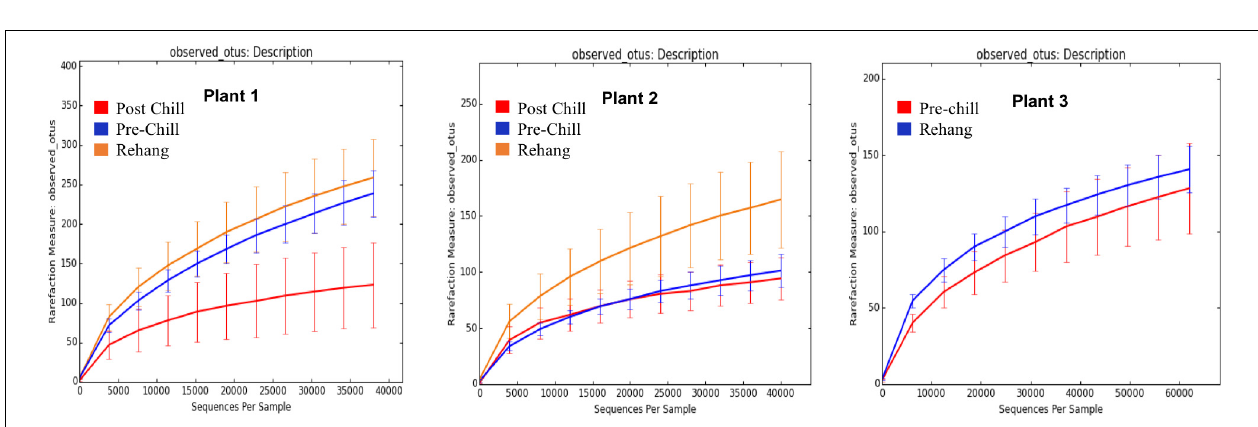
FIGURE 6 | Operational Taxonomic Unit (OTU) rarefaction curves. The number of observed OTU’s versus the length of sequence read at each processing plant and testing location within the plant.